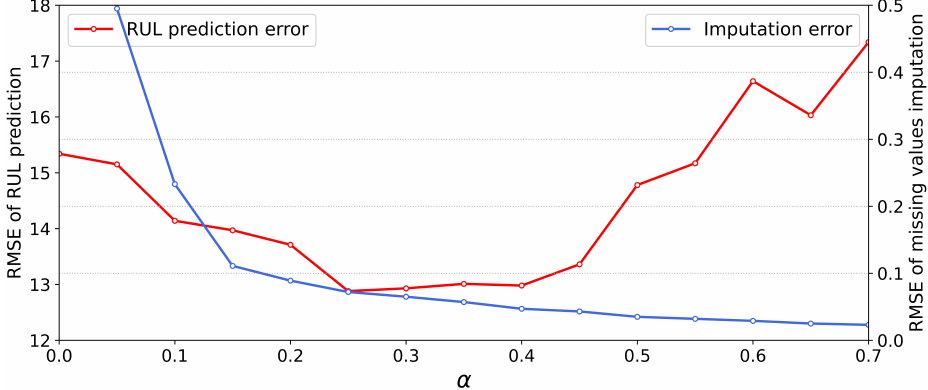
Figure 5. The RMSE of missing values imputation and RUL prediction under different α . The blue and red line represents the RMSE value of missing values imputation task and RUL prediction task, respectively. When α = 0 which means the missing values